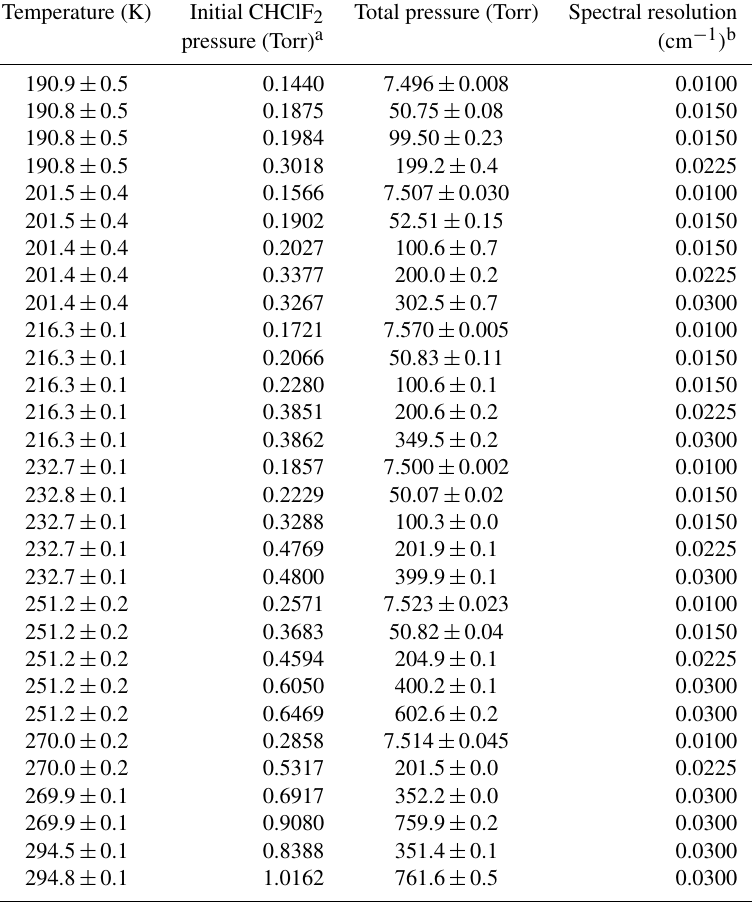
Table 2. Summary of the sample conditions for all